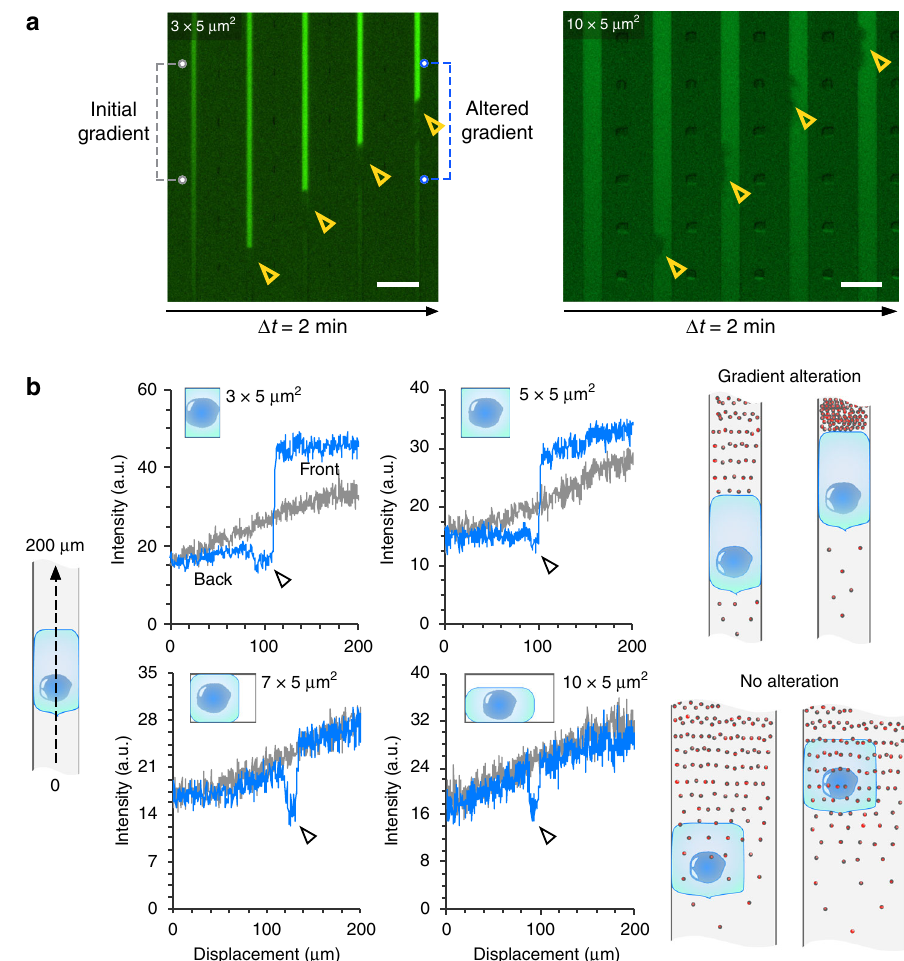
Fig. 5 Neutrophils alter the chemoattractant gradients in small channels. a Fluorescence kymographs showing the alternation of chemical gradient in the 3 × 5 µ m 2 , but not 10 × 5 µ m 2 channels. The yellow hollow arrows indicate the locations of one neutrophil at 2-min interval. The scale bar is 20 µ m. b Measurements of fl uorescent intensity pro fi le across the neutrophils in channels with (blue solid lines) and without (gray solid lines) the neutrophil at various channel cross-sections. The black arrows indicate the location of the neutrophil. The rightmost schematics illustrate the concept of gradient alternation caused by moving